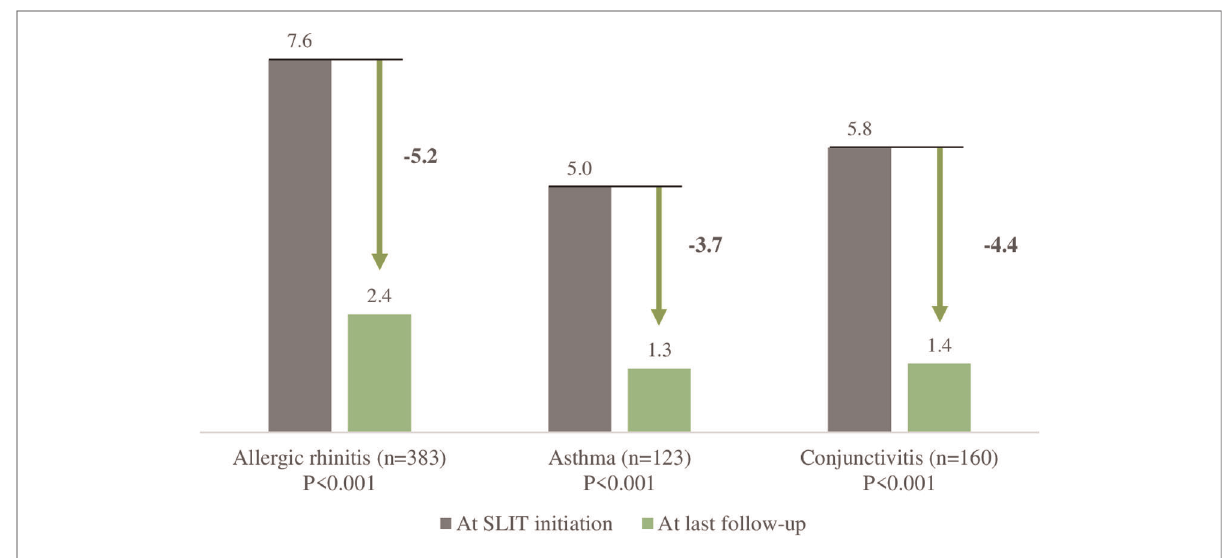
FIGURE 5 Changes in symptom severity during SLIT, as recorded on a VAS in the CRF by the